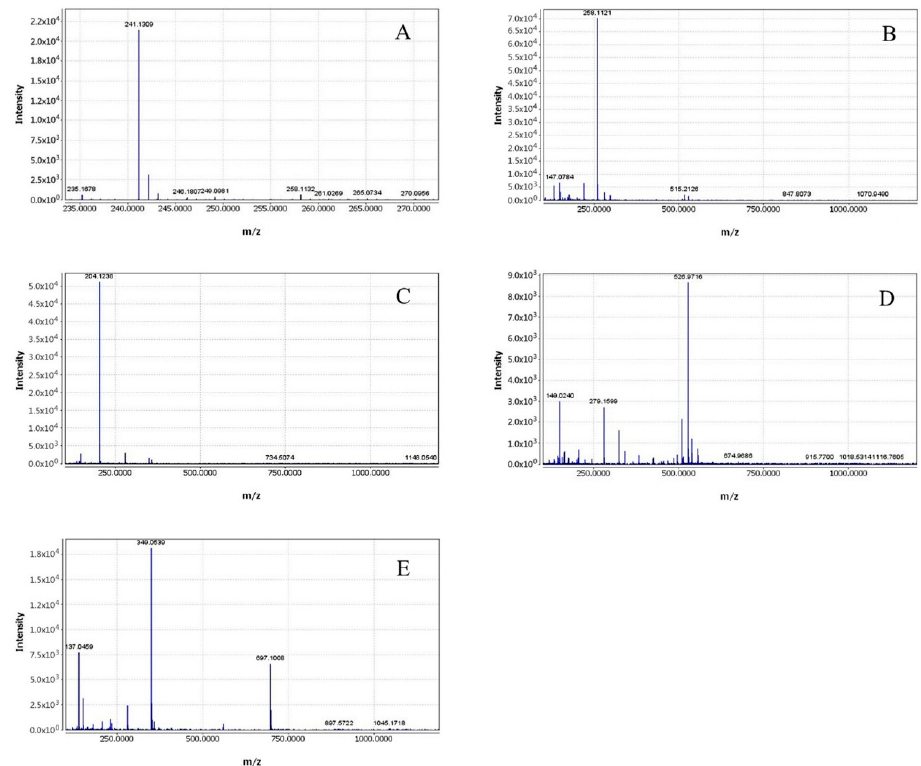
Figure 4. Mass spectra of identified metabolites. ( A ) L-anserine, ( B ) L- α -glycerylphosphorylcholine, ( C ) acetylcarnitine, ( D ) thiamine triphosphate, ( E ) adenosine thiamine diphosphate.